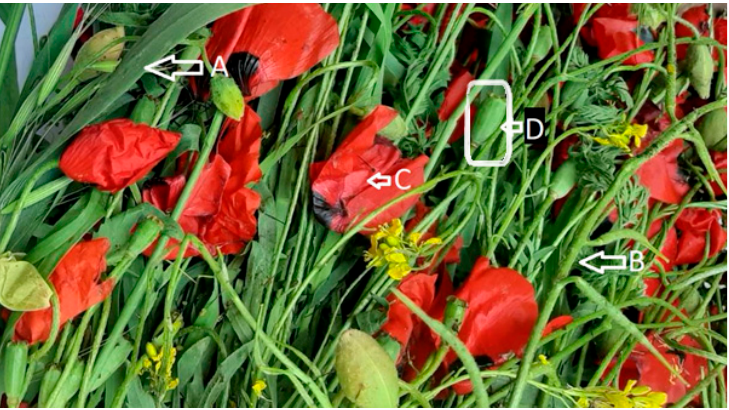
Figure 1. General appearance of P. decaisnei. (taken by A.A.J.). A, Leaves; B, Stems; C, Flowers; D, poppy